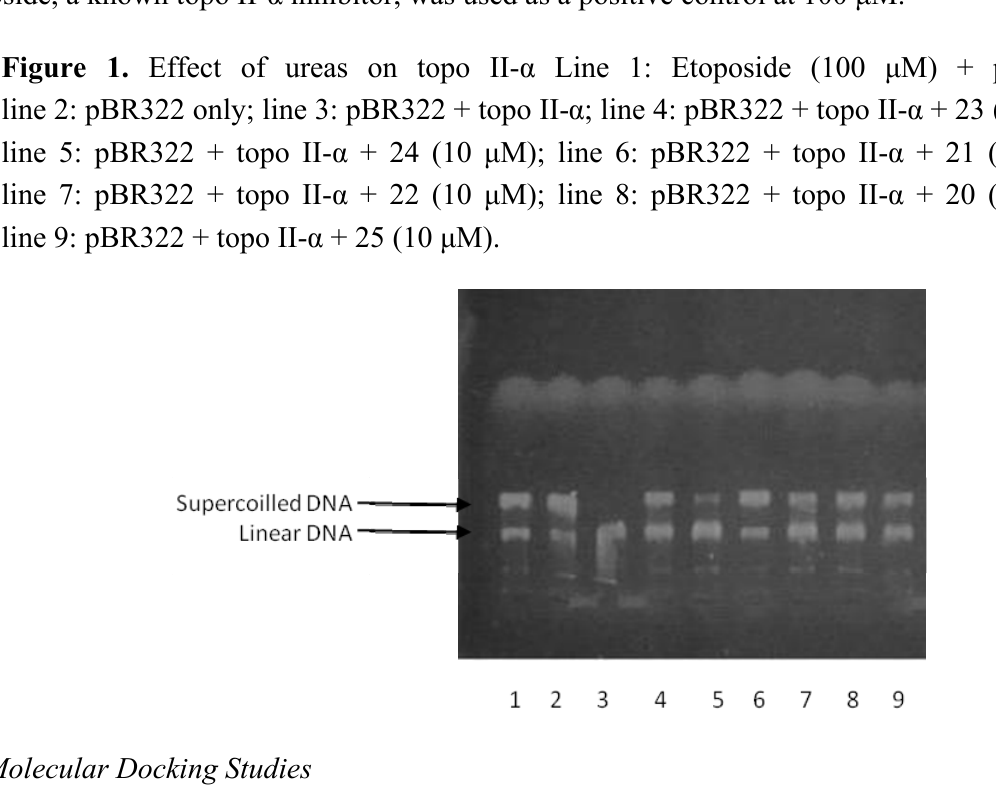
Figure 1. Effect of ureas on topo II- α Line 1: Etoposide (100 μ M) +